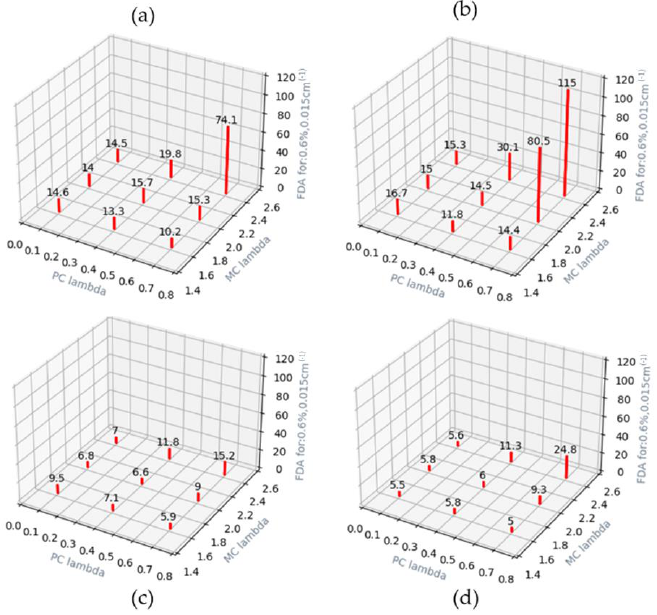
Figure 8. Extended range of simulations with different working conditions: ( a ) volume ratio 0.6%; nozzle area ratio 0.015 cm − 1 ; ( b ) volume ratio 0.6%; nozzle area ratio 0.035 cm − 1 ; ( c ) volume ratio 2.4%; nozzle area ratio 0.015 cm − 1 ; ( d ) volume ratio 0.6%; nozzle area ratio 0.035 cm − 1 .